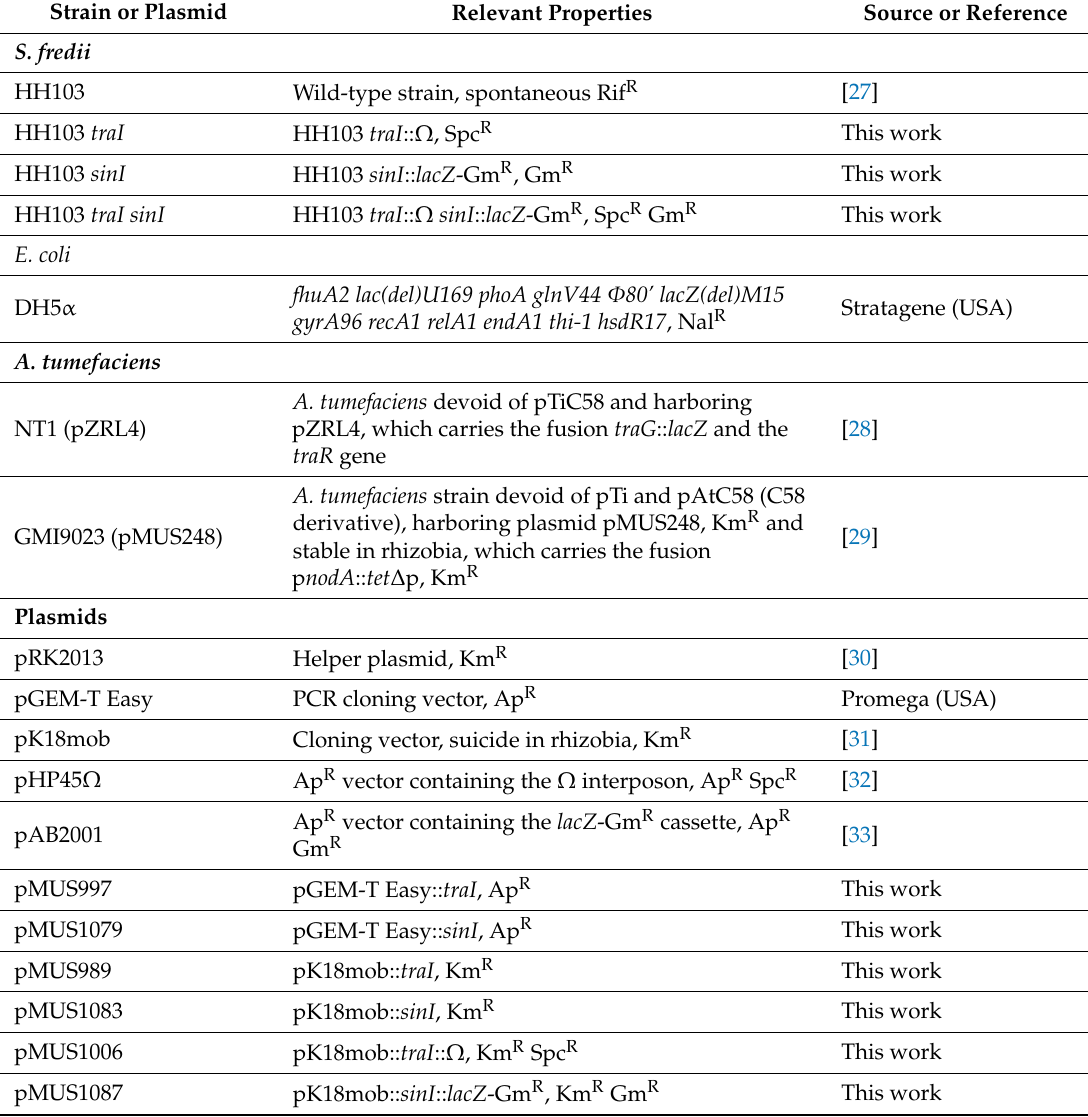
Table 1. Bacterial strains and plasmid used in this